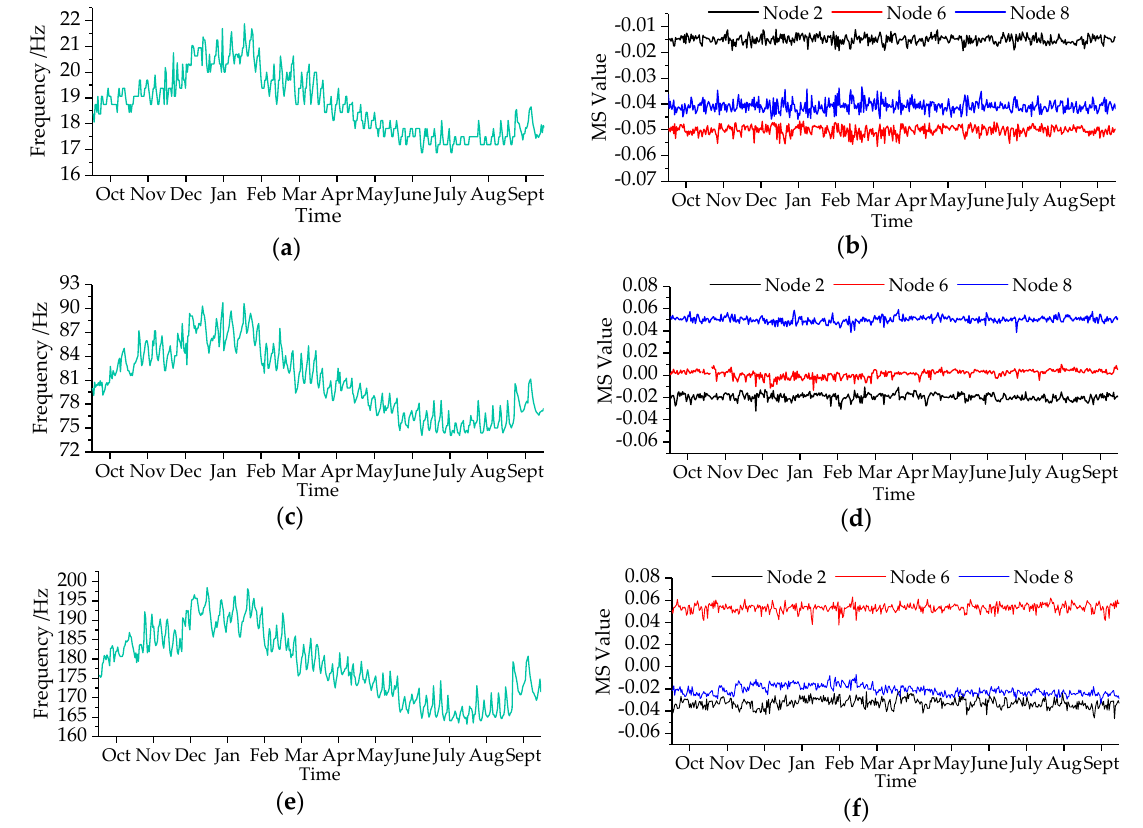
Figure 12. Modal parameters variations with months: ( a ) first order frequency; ( b ) first order MS; ( c ) second order frequency; ( d ) second order MS; ( e ) third order frequency; ( f ) third order MS.